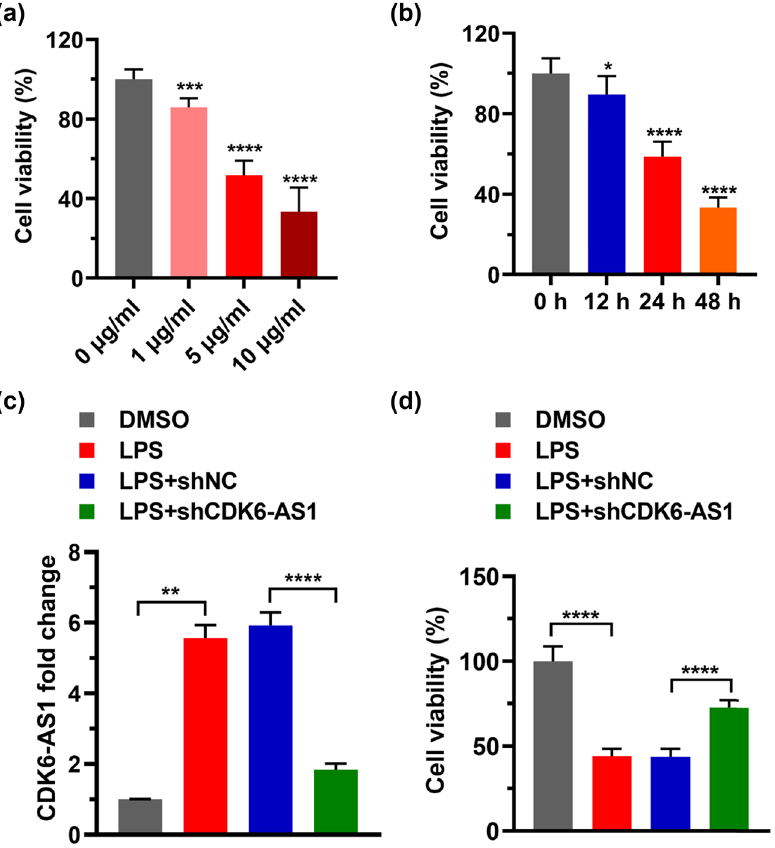
Figure 2: E ff ects of LPS and CDK6 - AS1 on cell viability: ( a ) cell viability after treatment with various concentrations of LPS, ( b ) cell viability after LPS treatment for various times, ( c ) relative levels of CDK6 - AS1 expression, and ( d ) e ff ect of LPS plus CDK6 - AS1 silencing on cell viability. ** P < 0.01, *** P < 0.001, **** P <